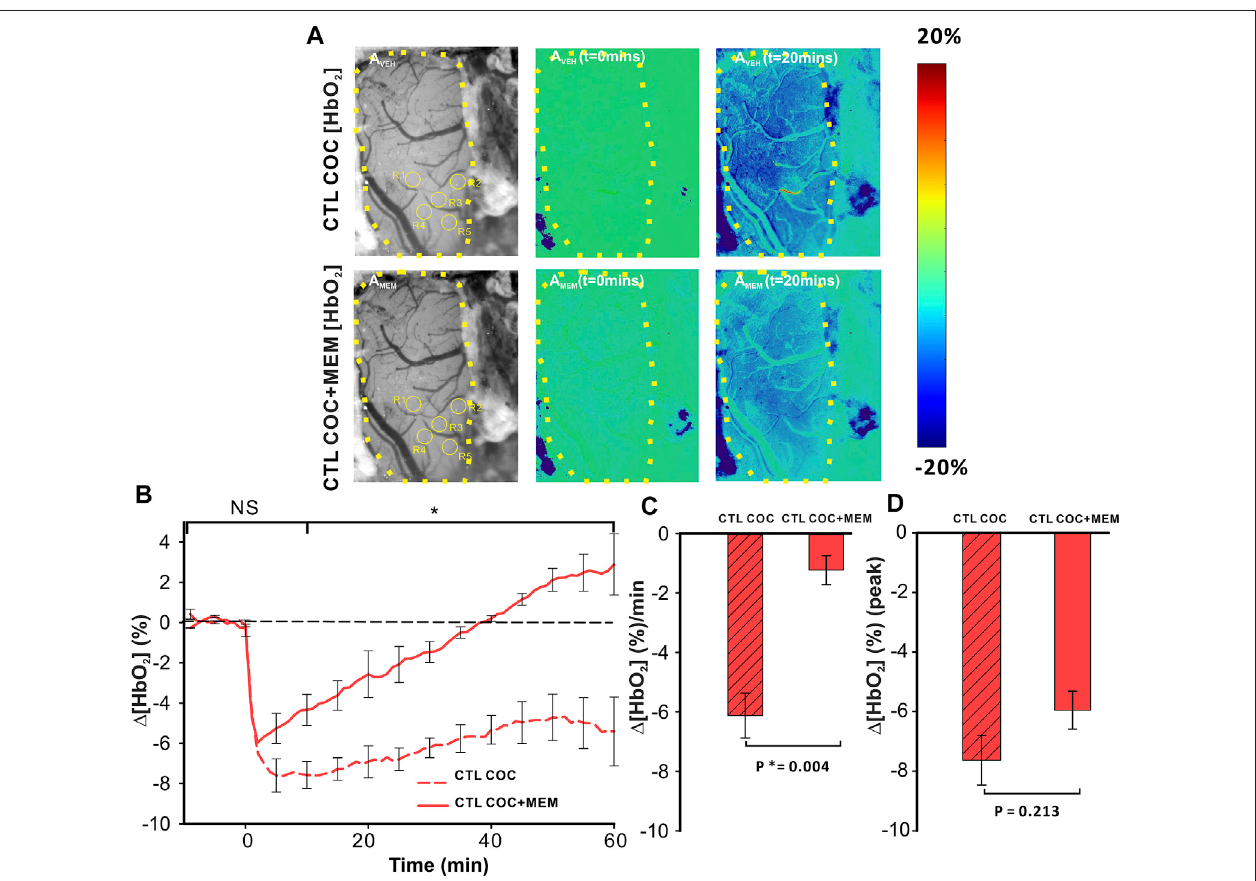
FIGURE5| Reductionof Δ [HbO 2 ]in thePFCofcontrolanimals inducedbycocaine isattenuatedfollowing memantine pretreatment. (A) Invivo imagingillustrating the time- and treatment-dependent reduction in oxygenated hemoglobin (HbO 2 ) following cocaine exposure in control rats pretreated with vehicle (upper panels) or memantine (lower panel). (B) Comparison of the time course for tissue oxygenation showed a faster recovery from cocaine-induced reduction in Δ [HbO 2 ] after memantine pretreatment. (C) Quanti fi cation of the total change in Δ [HbO 2 ] indicated that memantine pretreatment signi fi cantly improved Δ [HbO 2 ] decreases in response to cocaine even though it (D) did not signi fi cantly change the peak reduction in Δ [HbO 2 ]. Graphed values represent the mean and standard error. NS: not signi fi cant. *: p < 0.05, signi fi cant difference.